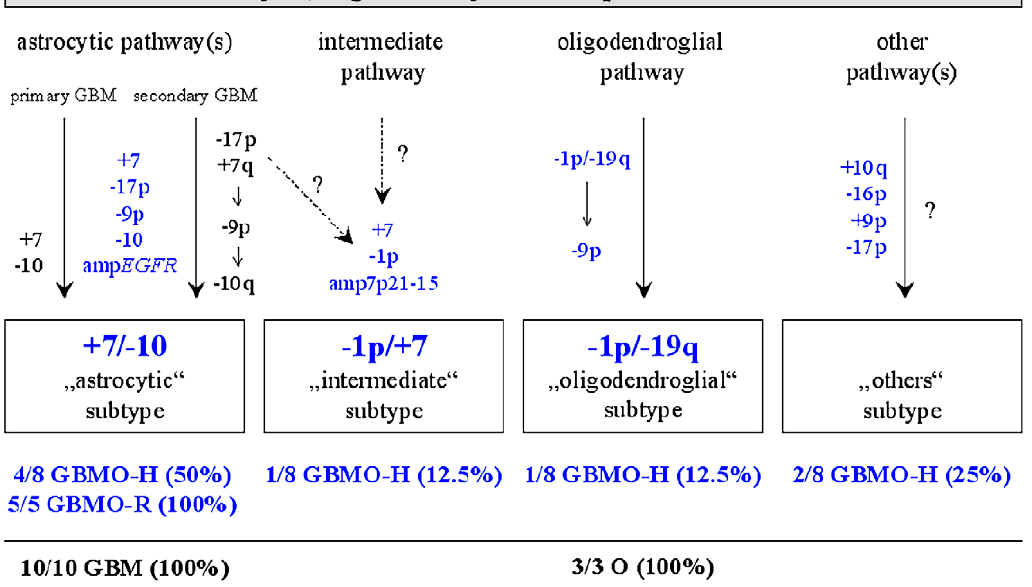
Fig. 4. Genetic subtypes in GBMO. We identified four different genetic subtypes (represented in boxes) by studying 13 GBMO, indicating at least four genetic pathways leading to GBMO (an “astrocytic”, “intermediate”, “oligodendroglial” and “other” pathway). Genetic changes found in the GBMO were marked in blue. Abbreviations: GBMO-H – GBM with oligodendroglial component and honeycomb appearance; GBMO-R – GBM with oligodendroglia-like, round tumor cells; GBM – “classic” glioblastoma; O –